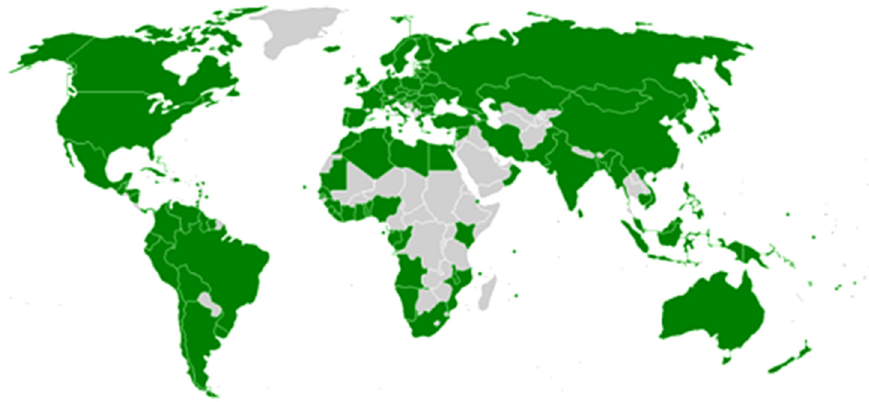
Figure 10. Countries having signed MARPOL agreements.